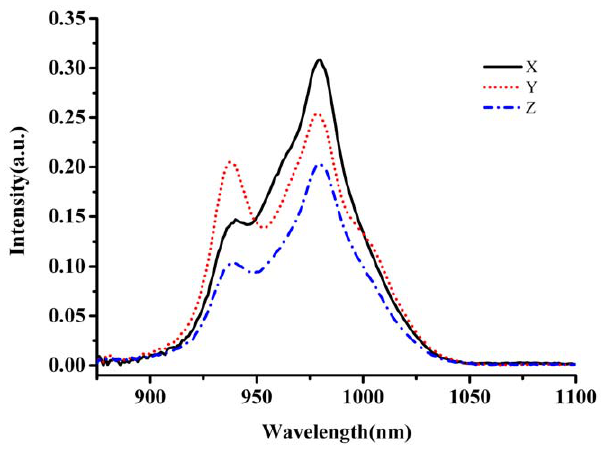
Figure 5. Polarized absorption cross-section of Yb 3 + :KBaGd(- MoO 4 ) 3 crystal at room